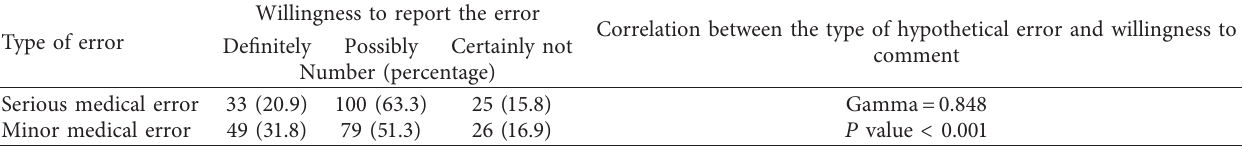
Table 3: The interns’ willingness to report the medical